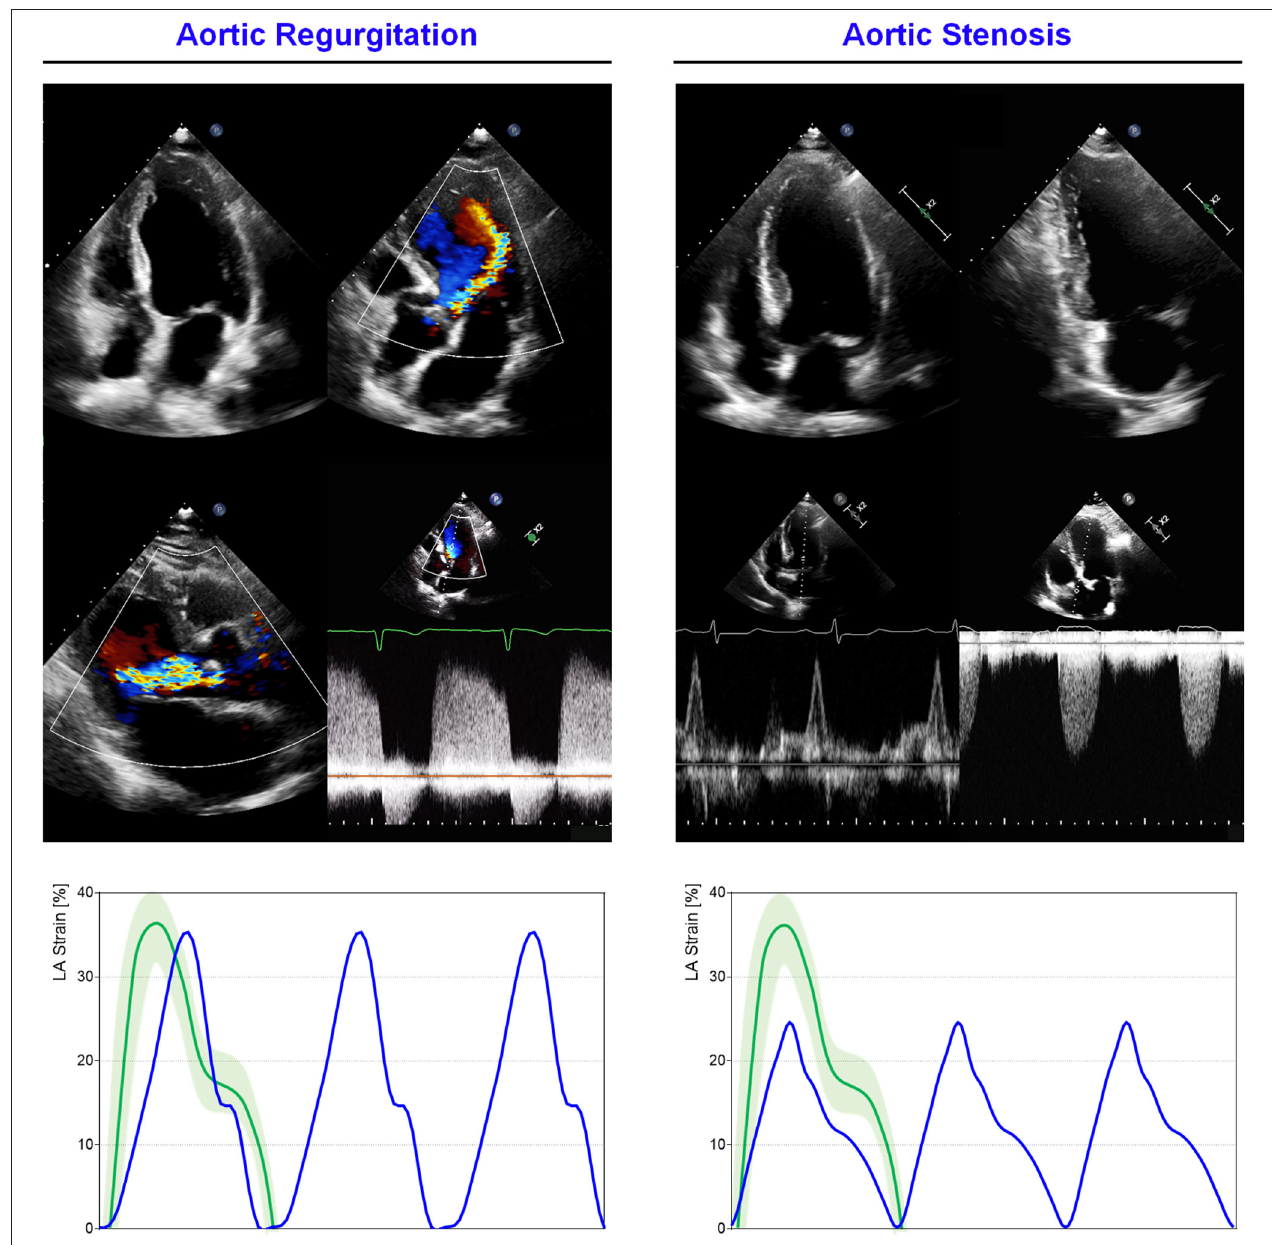
FIGURE 4 | LA mechanics in aortic valve diseases: Examples of echocardiographic images and LA strain are shown for (left) severe aortic regurgitation (AR); (right) severe aortic stenosis (AS). Strain traces are cartoons realized with real values of the reported cases. Reference values for LA strain are shown in green. Note that reservoir function in AS is impaired, consistently with increased LA pressures secondary to concentric LV hypertrophic remodeling, while in AR the degree of reservoir impairment is lower. Abbreviations as in the